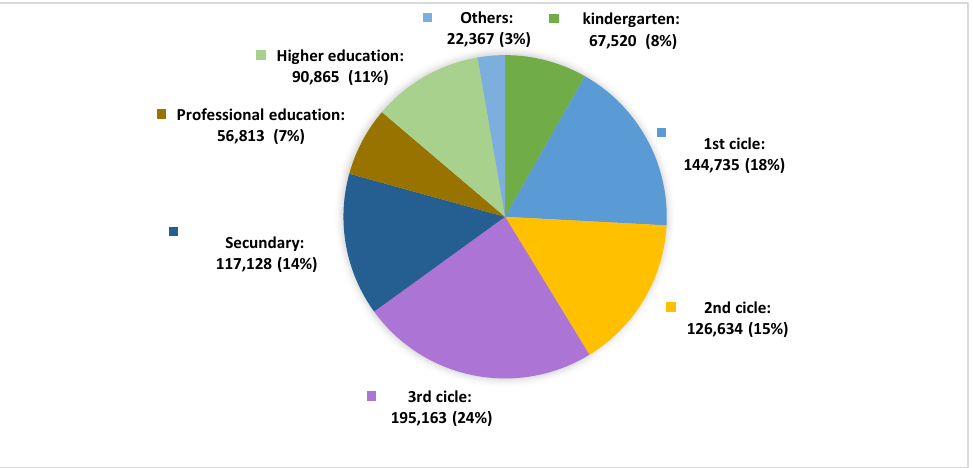
Figure 3. Eco-Schools in numbers: students involved by level of education. Source: (ABAE 2021, 2022a).